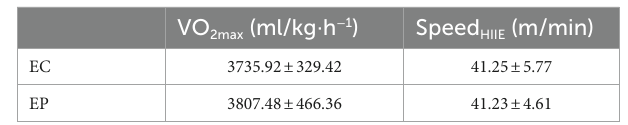
TABLE 1 VO 2max and Speed HIIE in HIIE rats( x ±